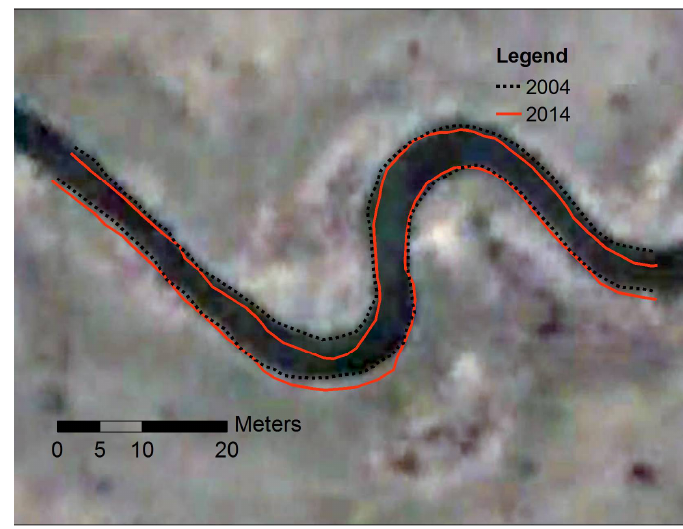
Figure 8. Channel margin migration along the M3 sampling reach. Flow from left (west) to right (east). Background image adopted form Google Earth image (2004).